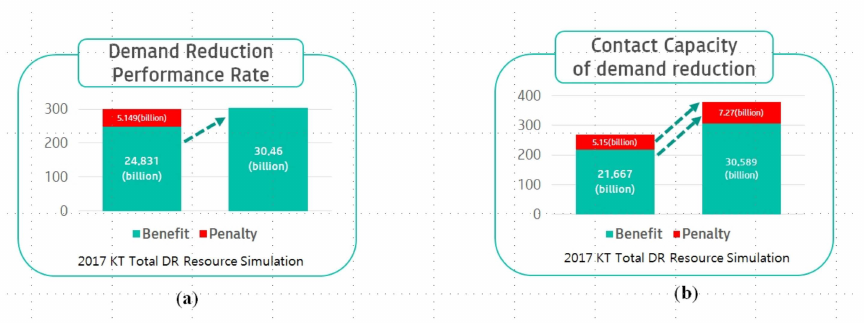
Figure 8. Simulation results of KT blockchain-based DR services with respect to ( a ) demand reduction performance rate and ( b ) contract capacity of demand reduction.